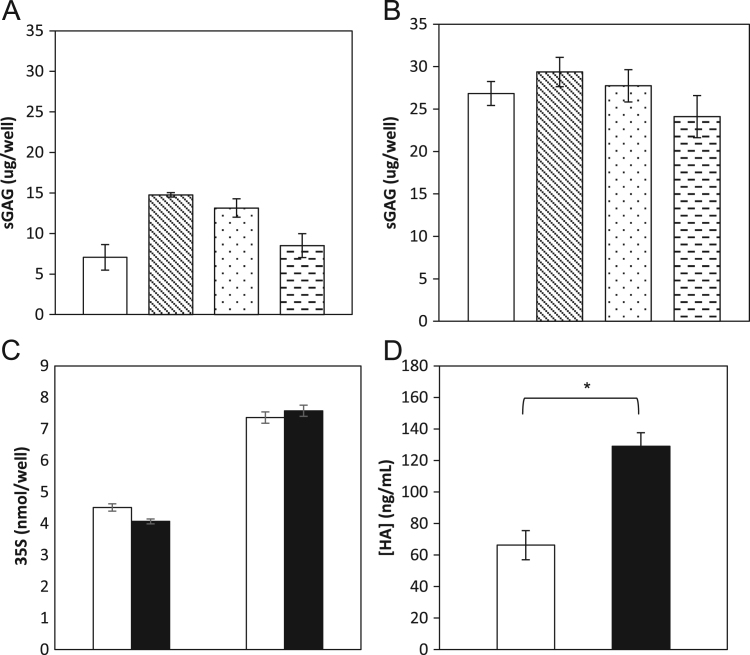
(A) sGAGs produced per EpiDerm well measured in the media by the Blyscan sulfated glycosaminoglycan assay (left to right: control – open bar, 1 day xanthophyll treatment, 2 day xanthophyll treatment, 3 day xanthophyll treatment). No significant difference between control and treated samples (p=0.336). (B) sGAGs bound to EpiDerm tissue released by papain digest, then measured by the Blyscan sulfated glycosaminoglycan assay (left to right: control, 1 day xanthophyll treatment, 2 day xanthophyll treatment, 3 day xanthophyll treatment). (C) sGAG produced per EpiDerm tissue digest at 24 and 72 h measured by 35S-sulfate labeling. No significant difference was found between control (open bars) and treated samples (filled bars) at 24 or at 72 h (p=0.141, p=0.646). (D) Hyaluronan in EpiDerm tissue media at 24 h measured by an enzyme-linked competitive binding assay (control, open bar; xanthophyll treated, filled bar). A significant increase in hyaluronan production was found as a result of lutein/zeaxanthin treatment (n=3, p=0.0019).